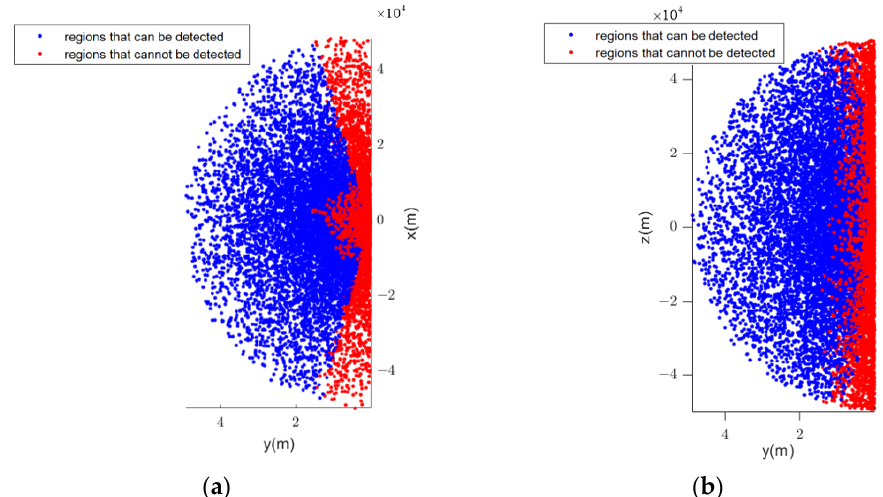
( b ) Figure 8. Collaborative detection formation scheme: ( a ) The nano-satellite conducts natural flight relative to the space station; ( b ) the nano-satellite and the space station remain in the following flight state. 3.2. Efficiency Analysis of Collaborative Detection According to the two typical observation schemes given based on the above, the relationship between the relative orbital parameters of the nano-satellite and collaborative observation results is analyzed. The early-warning region is set to be the hemisphere of r = 50 km in the LVLH coordinate system in front of the y axis of the space station. The camera swing angular velocity is taken as 0.5 / ,